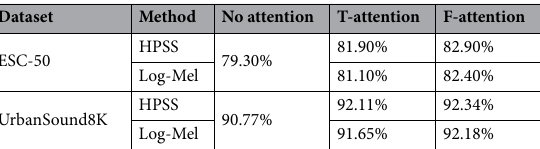
Table 4. Comparison of attention mechanisms generated by different